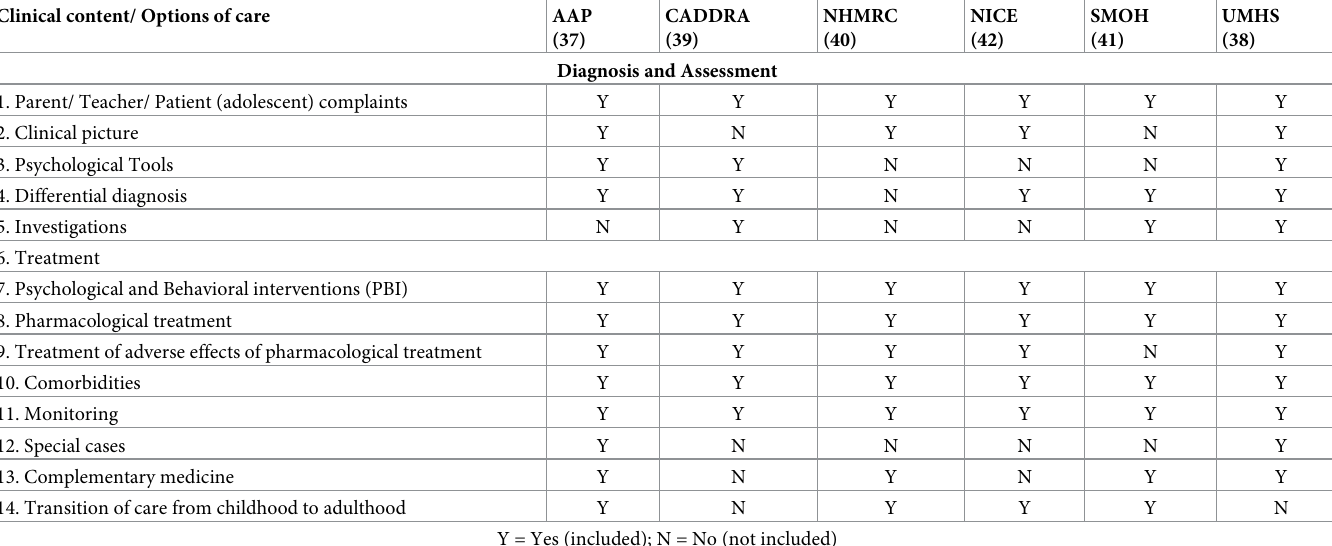
Table 2. Characteristics of the ADHD clinical practice guidelines (clinical content/ options of